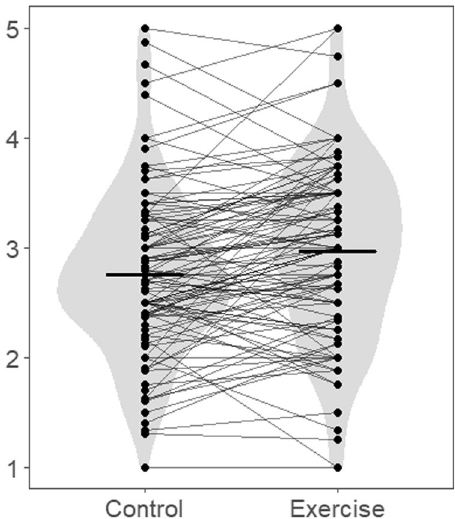
Fig. 1 Violin plot for means within individuals and means between conditions of vigour in the exercise and control conditions. The dots represent the means within the individual, and the bars represent the means between the